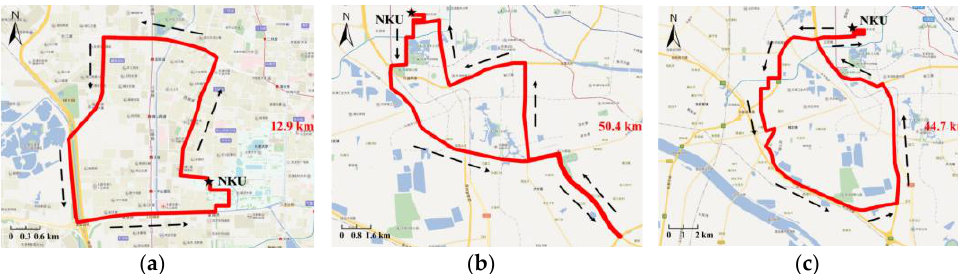
Figure 5. The test routes for different types of vehicles; ( a ) Rout A for LDV, MDV and LDT; ( b ) Route B for LDV, MDV and HDV; ( c ) Route C for HDV, MDT and HDT